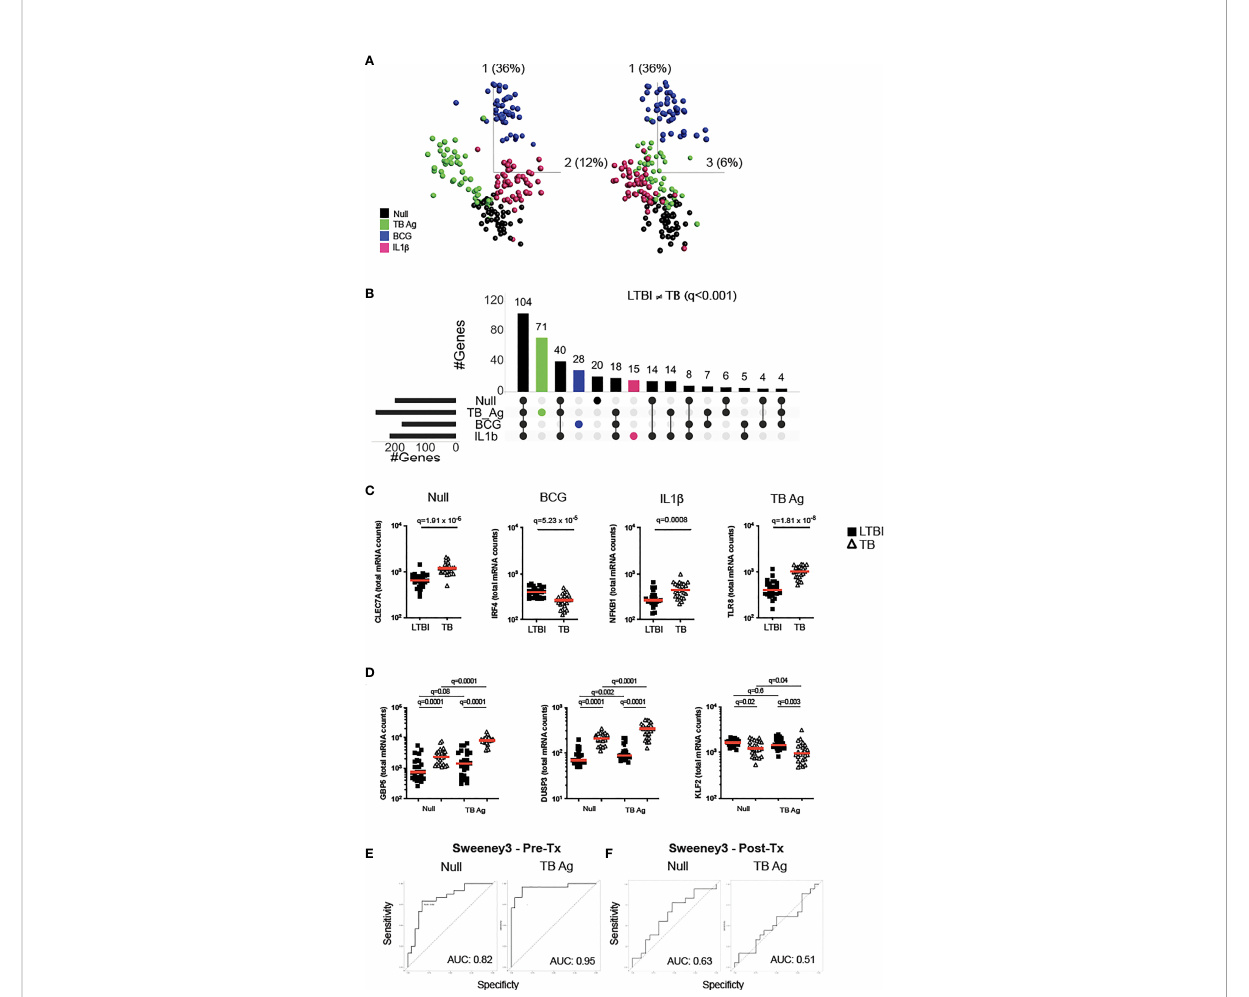
FIGURE 1 Immune stimulation identi fi es speci fi c gene expression differences between latent M.tb infection and active TB disease. (A) Principal component analysis (PCA) on expression of 622 genes from 24 individuals with latent M.tb infection (LTBI) and 24 with active TB disease (TB) after whole blood stimulation with TB Ag, BCG, IL-1 b , and a non-stimulated control (Null). Each coloured circle represents one individual (LTBI or TB) for each condition. (B) Upset plot showing the intersection of differentially expressed genes (q value <0.001, Mann-Whitney corrected for multiple comparisons) between TB and LTBI, across the four stimulations. Coloured bars depict the number of differentially expressed genes between LTBI and TB for each speci fi c stimulation (TB Ag – green; BCG – blue; IL-1 b - pink). (C) Examples of signi fi cantly different stimuli-speci fi c transcripts (q<0.001) between TB and LTBI. (D) Expression of the 3 genes from the Sweeney TB score (Sweeney3) in the Null and TB Ag conditions on visit 1 pre-treatment. Area under the receiver operating characteristic curve (AUC) for discrimination of LTBI/TB groups using Sweeney3 for the Null and TB Ag conditions on visit 1 pre-treatment (Pre-Tx) (E) and on visit 2 after successful antibiotic treatment (Post-Tx) (F) . Comparisons of LTBI/TB groups within the same stimulation were performed using unpaired non-parametric t-tests; comparisons between Null and stimulated conditions within the LTBI/TB groups were performed using a paired non-parametric t-test. Correction for multiple comparisons was then applied. Red line: median values. Closed square: LTBI, Open triangle: TB. For panels (C, D) , q values (false discovery rate-adjusted p values) are